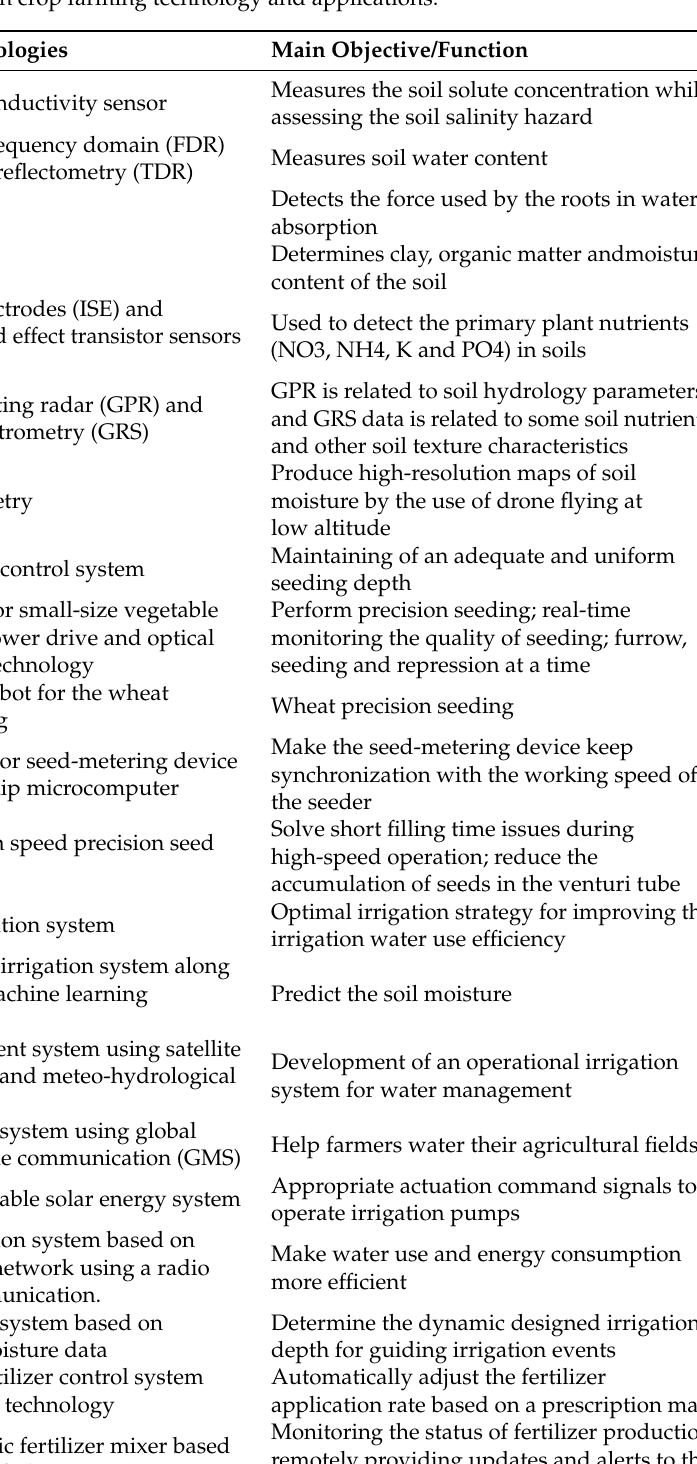
Table 1. Overview of precision crop farming technology and